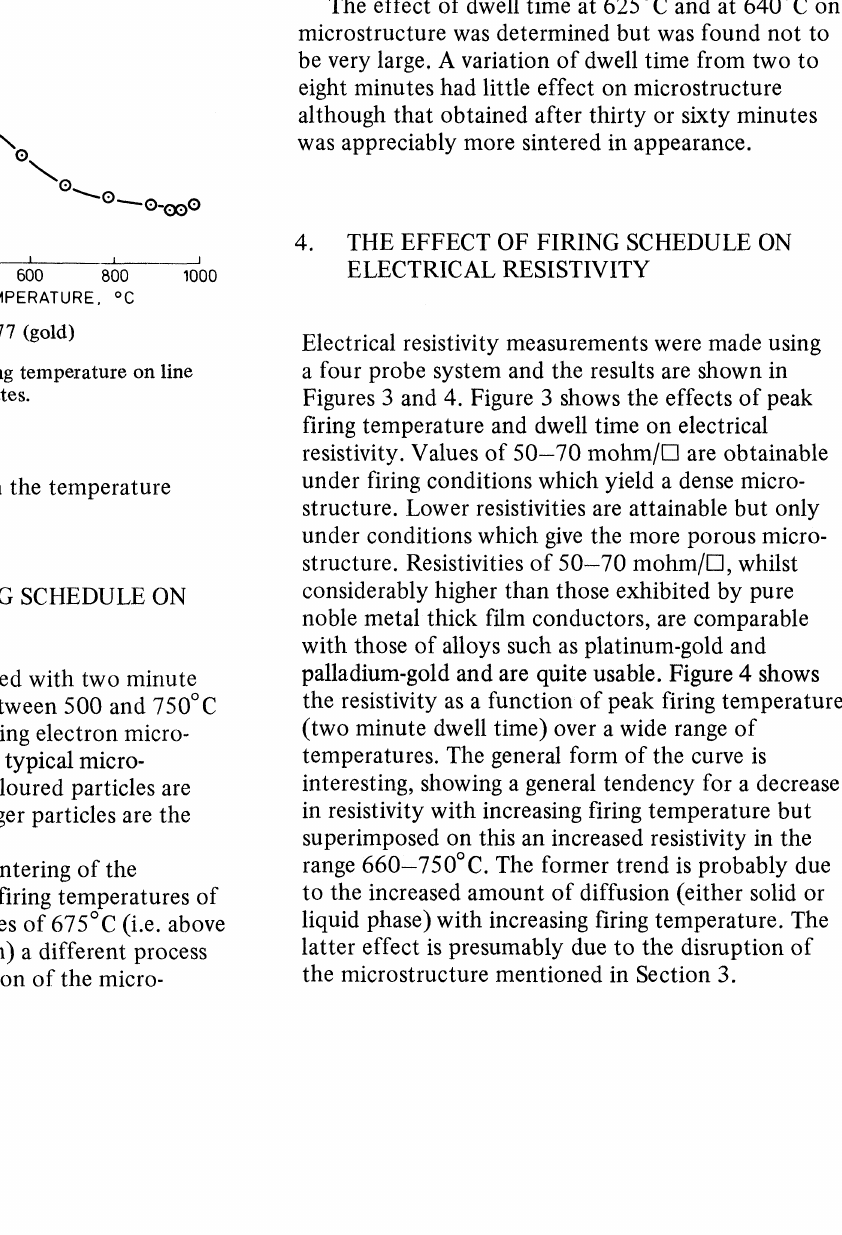
FIGURE The effect of firing temperature on line thickness for two thick film pastes.